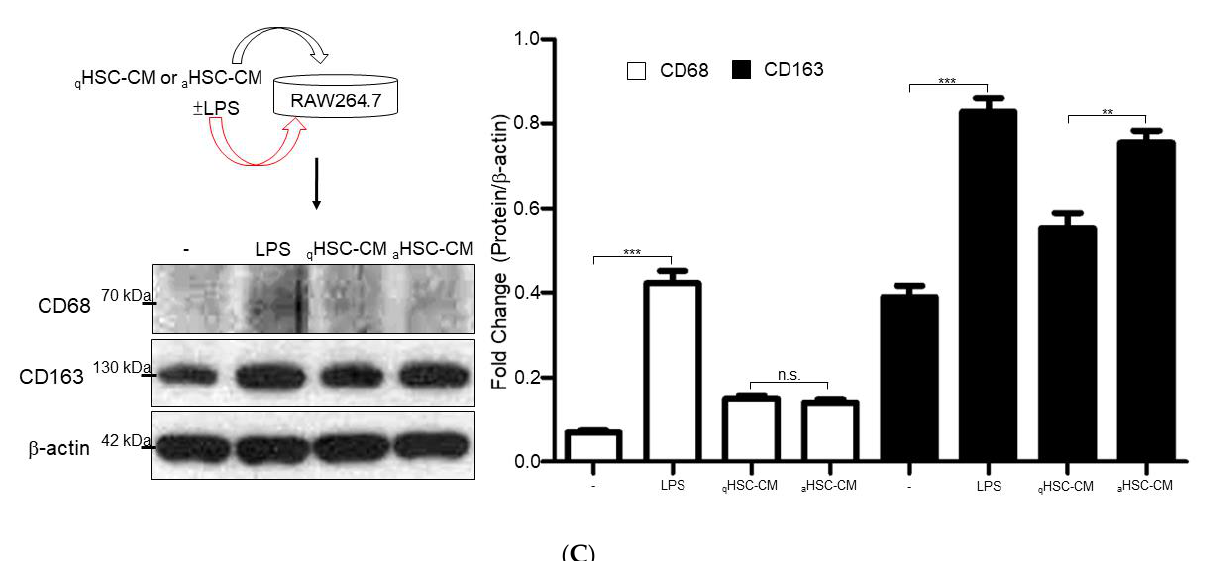
Figure 4. Network analysis to predict the influence of activated HSCs on phenotype shift of macrophages. ( A ) Top-ranked pathways from the GeneGo MetaCore ™ pathway analysis are indicated. Pathways were ranked according to p values, and bars represent the inverse log of the p values. ( B ) Upper panels: the expression levels and patterns of peritumoral infiltrated CD68 + macrophages in different stages of HCC samples. Lower panels: the expression levels of CD163 + as indicated by red arrows were significantly increased in the advanced stage of HCC. (bar scale 200 μ m) ( C ) RAW264.7 cells were cultured with LPS, aHSC-CM, and qHSC-CM. The expression levels of CD68 and CD163 were determined by Western blotting analysis and β -actin was used as an internal control. The quantitative results were demonstrated as bar charts (** p < 0.01, *** p < 0.001, n.s. indicated no significance).